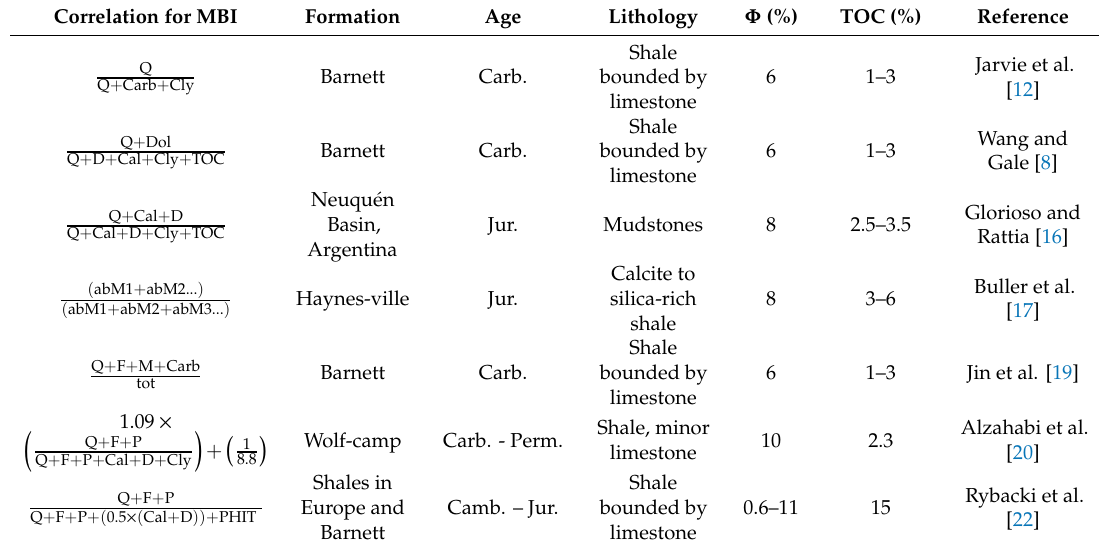
Table 1. Summary of MBI correlations based on the mineral